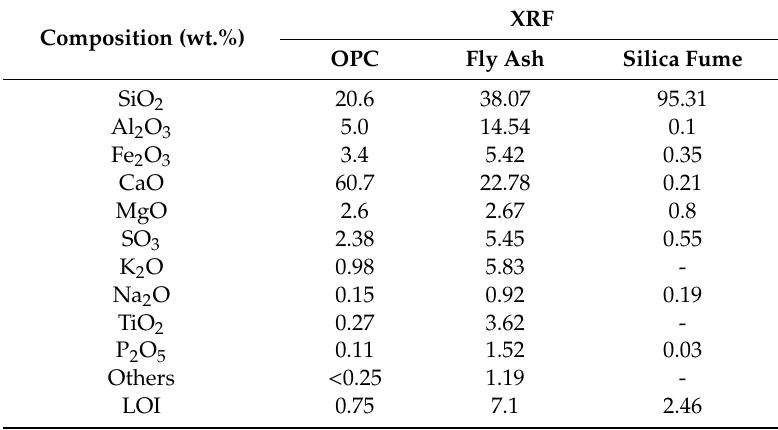
Table 1. Chemical composition of binder materials used in this